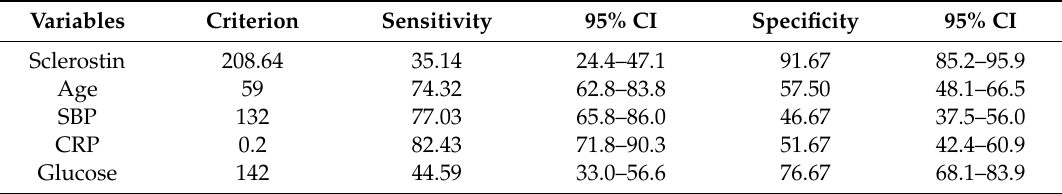
Table 5. The best cut-o ff values of each variables at predicting central arterial sti ff ness of dialysis patients by receiver operating characteristic (ROC) curve